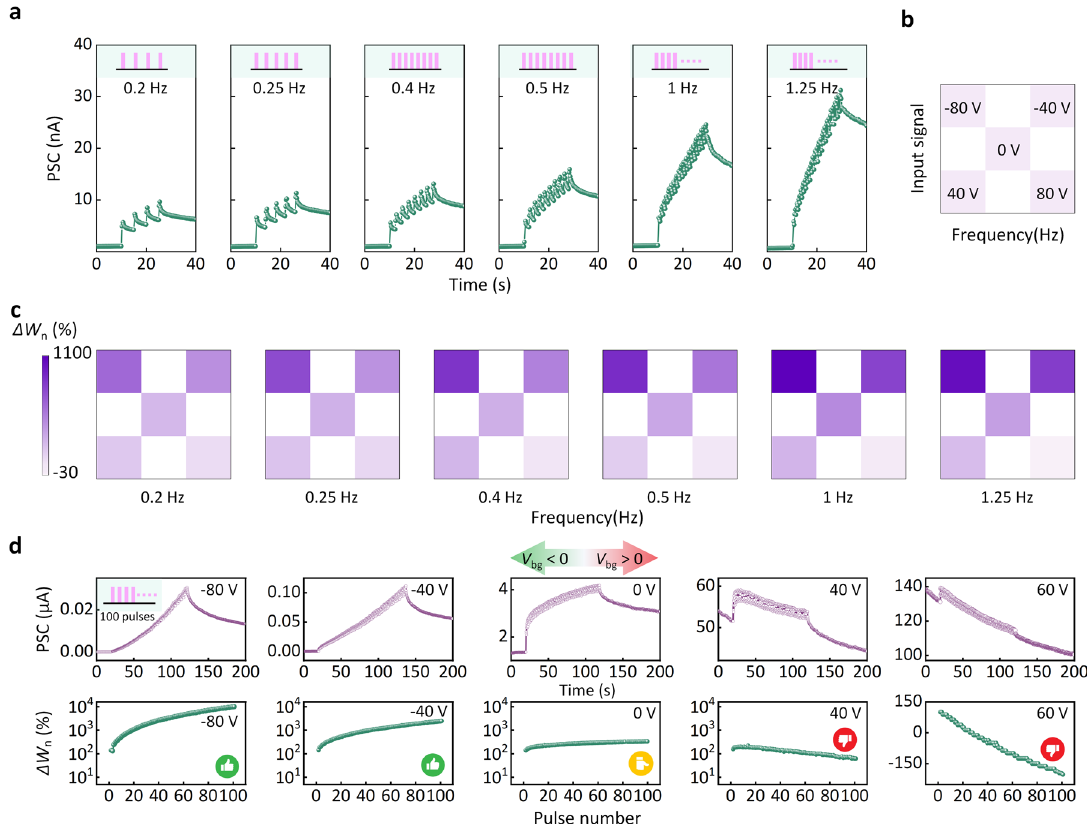
Fig. 4 Metaplasticity in the InSe synaptic devices under various frequencies and numbers of presynaptic spikes. a PSC generated by presynaptic illumination with a 405-nm laser (0.245 W cm − 2 , 500 ms) with diverse frequencies of 0.2, 0.25, 0.4, 0.5, 1, and 1.25 Hz, at V bg = − 40 V. b Diagram showing different gate voltages represented by elements of the matrix. c Maps for weight change of the PSC ( Δ W various V bg at the aforementioned frequencies. d PSC responses triggered by a train of 100 presynaptic spikes and the corresponding Δ W n under different V bg ranging from − 80 to 60